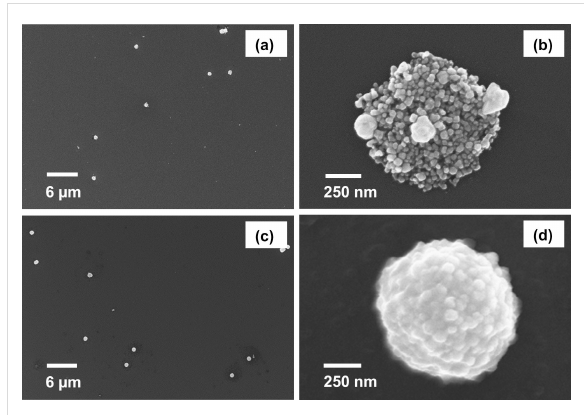
Figure 4: SEM images of (a, b) porous silver nanocapsules with hydrogel cores and (c, d) complete silver nanocapsules with hydrogel